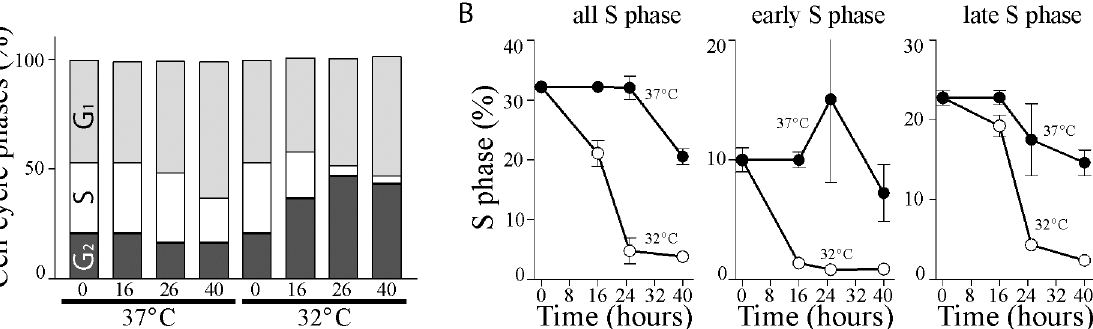
Fig 1. G 1 and G 2 arrest are induced at the permissive temperature in HT29tsp53 cells. (A) Two parameter flow cytometric analysis was used to determine cell cycle distribution as a function of DNA content (PI stain) and DNA replication (BrdU incorporation). Each column represents the percentage of cells under each condition in each phase of the cell cycle. (B) The S phase population in (A) was further separated into early and late S phase based on DNA content and plotted as a function of time. Each value in (A) and (B) were determined from the same experiments and each represents the mean ( ± SEM) determined from a minimum of 3 independent